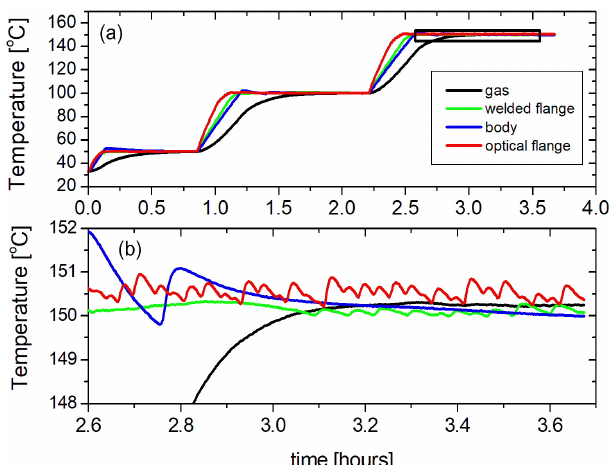
Figure 8. (a) Heating and temperature stabilization in three steps. (b) Temperature stability of the different parts of the cell and the gas during active stabilization (enlarged part of panel a , indicated as a black box in panel a